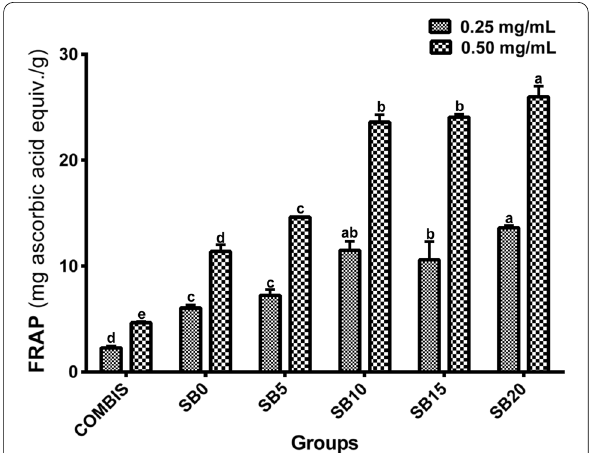
Fig. 1 Ferric reducing antioxidant potential of plantain-shallot biscuits. Values are expressed as mean letters are significantly different at p < 0.05. COMBIS: Commercial onion biscuit; SB0: 100% Plantain biscuit, SB5: 95% Plantain Shallot biscuit, SB10: 90% Plantain Plantain 15% Shallot biscuit, SB20: 80% Plantain + biscuit